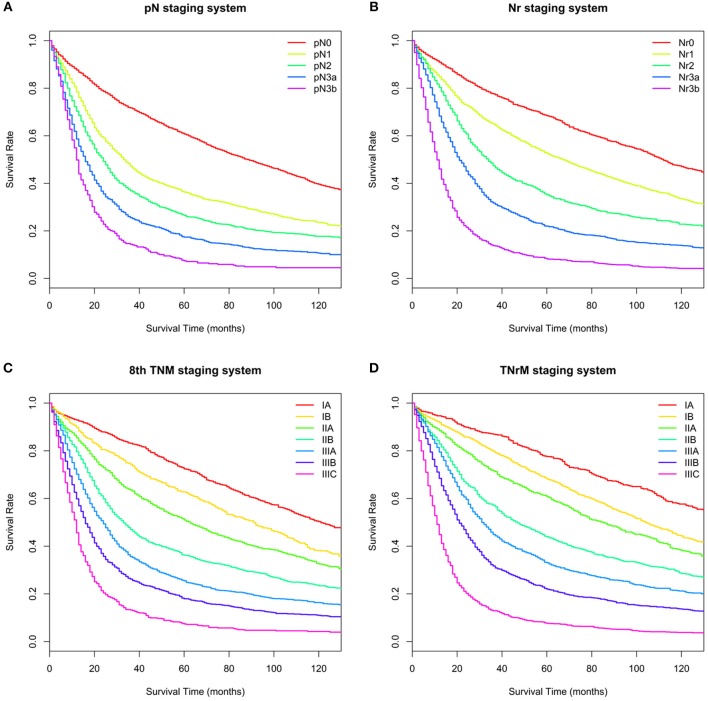
Overall survival (OS) for the training set based on different staging systems. (A) pN staging system. Five-year OS for the pN categories (pN0–3b) was 60.7, 36.3, 26.5, 17.4, and 7.4%, respectively. (B) Nr staging system. Five-year OS for the Nr categories (Nr0–3b) was 68.4, 52.5, 35.3, 22.0, and 8.2%, respectively. (C) 8th TNM staging system. Five-year OS for the 8th TNM stages (IA–IIIC) was 72.4, 62.8, 51.0, 36.3, 25.5, 18.0, and 7.4%, respectively. (D) TNrM staging system. Five-year OS for the TNrM stages (IA–IIIC) was 77.6, 68.2, 60.7, 44.0, 33.1, 22.0, and 7.7%, respectively.